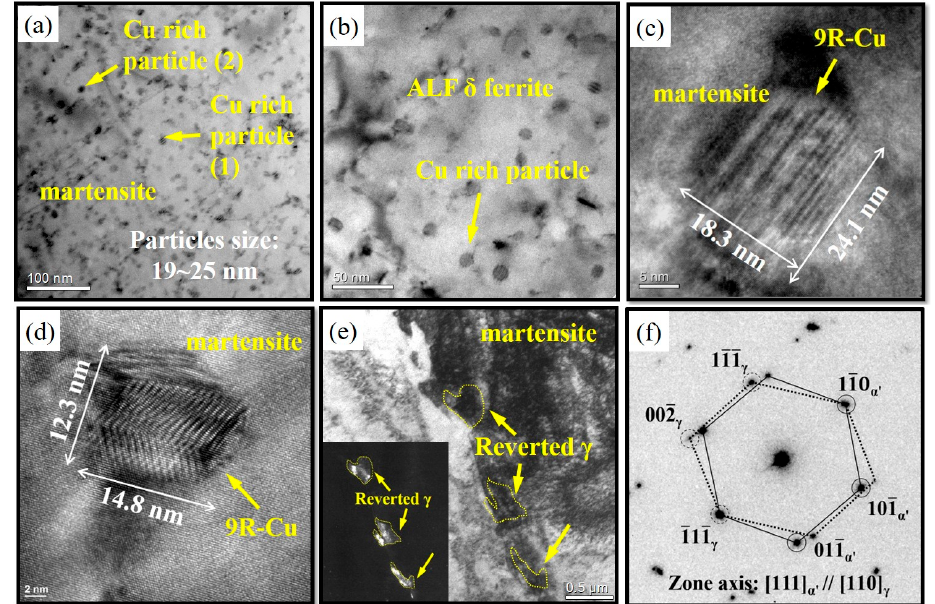
Figure 7. Samples aged for 1 h at 600 °C after H2O-quenched solid solution treatment. ( a ) Cu-rich particles in martensite matrix; ( b ) enlarged magnification of nano Cu-rich particles in ALF δ ferrite matrix; ( c ) enlarged 9R-Cu in ( a ) martensite with the Moiré fringes of parallel bands; ( d ) 9R Cu-rich precipitates with zigzag or herring-bone pattern of interference fringe; ( e ) collapsed lath martensite embedded reversed γ dark field of reversed γ at bottom left; ( f ) orientation relationship (OR) between martensite α ’ and reversed austenite γ .